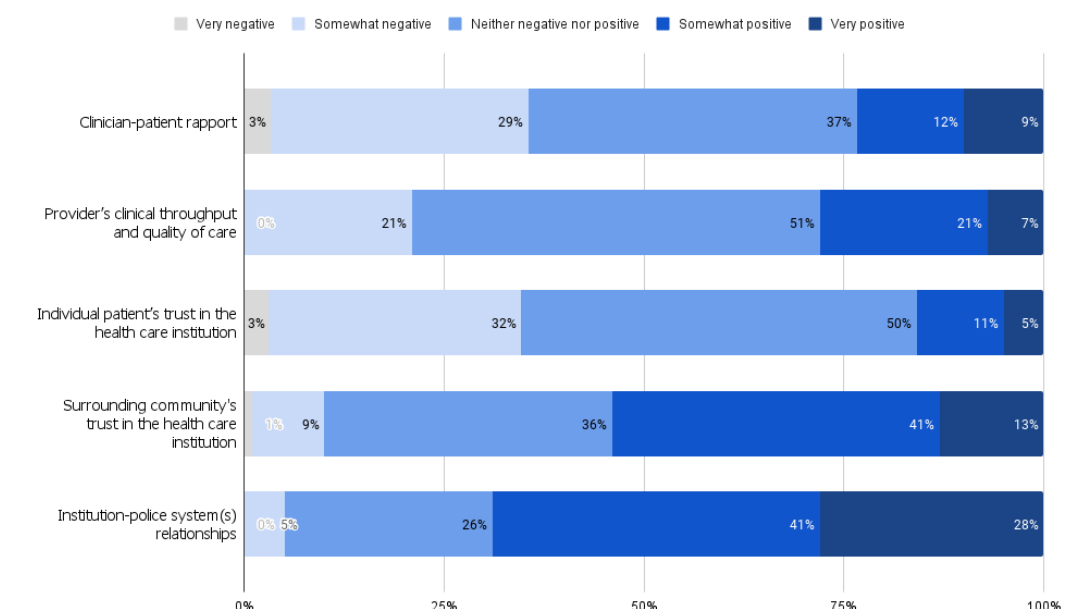
Figure 2. Emergency physician perceptions of the impact of law enforcement officer activity on clinical and community